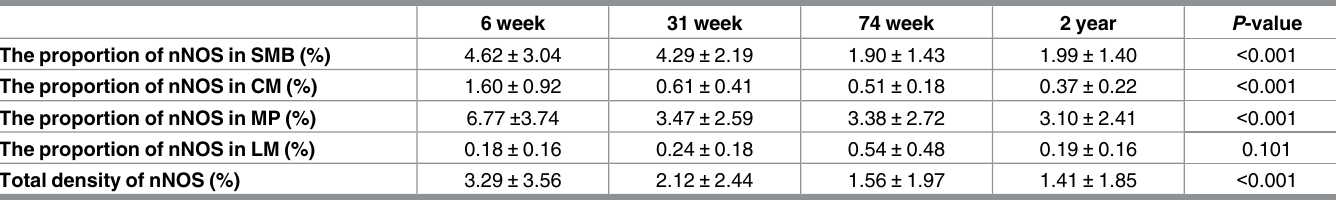
Table 2. The proportion of the nNOS positive area in the corpus of four different aged rat stomach (all, n =